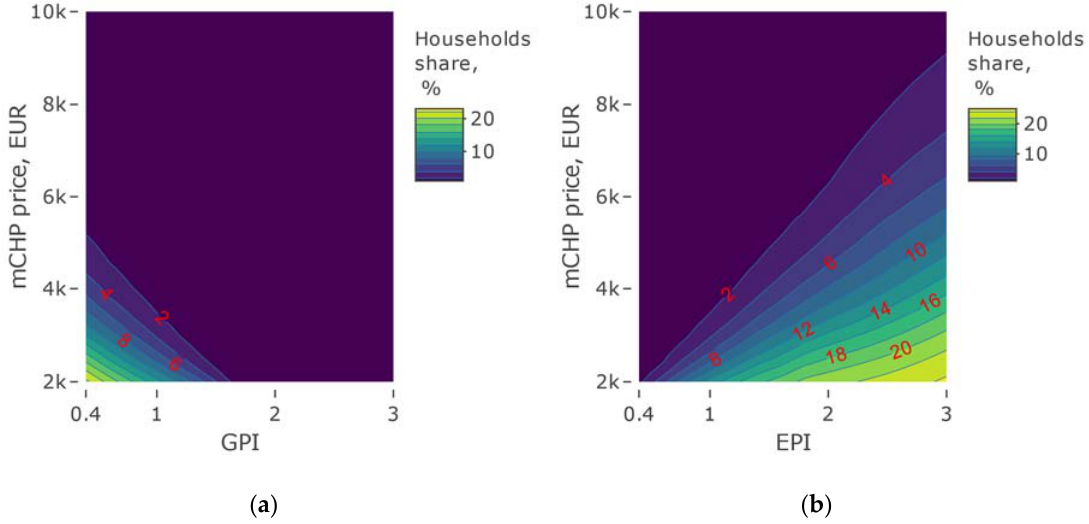
Figure 12 . Household share for: ( a ) EPI = 1.0 and different GPI; ( b ) GPI = 1.0 and different EPI.